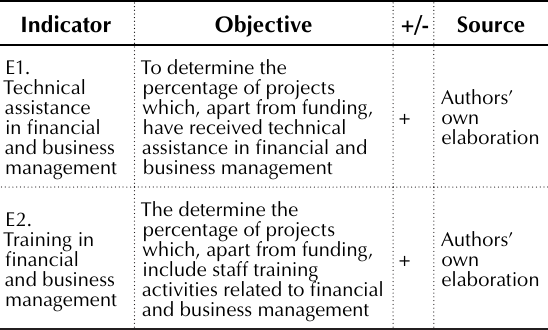
Table 6. Indicators of non-financial support for inclusion